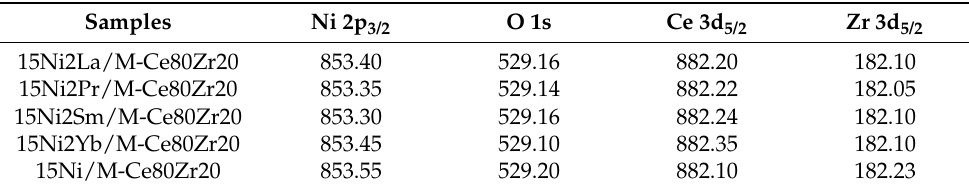
Table 2. Binding energies (eV) of the surface elements of the catalysts based on X-ray photoelectron spectroscopy (XPS).